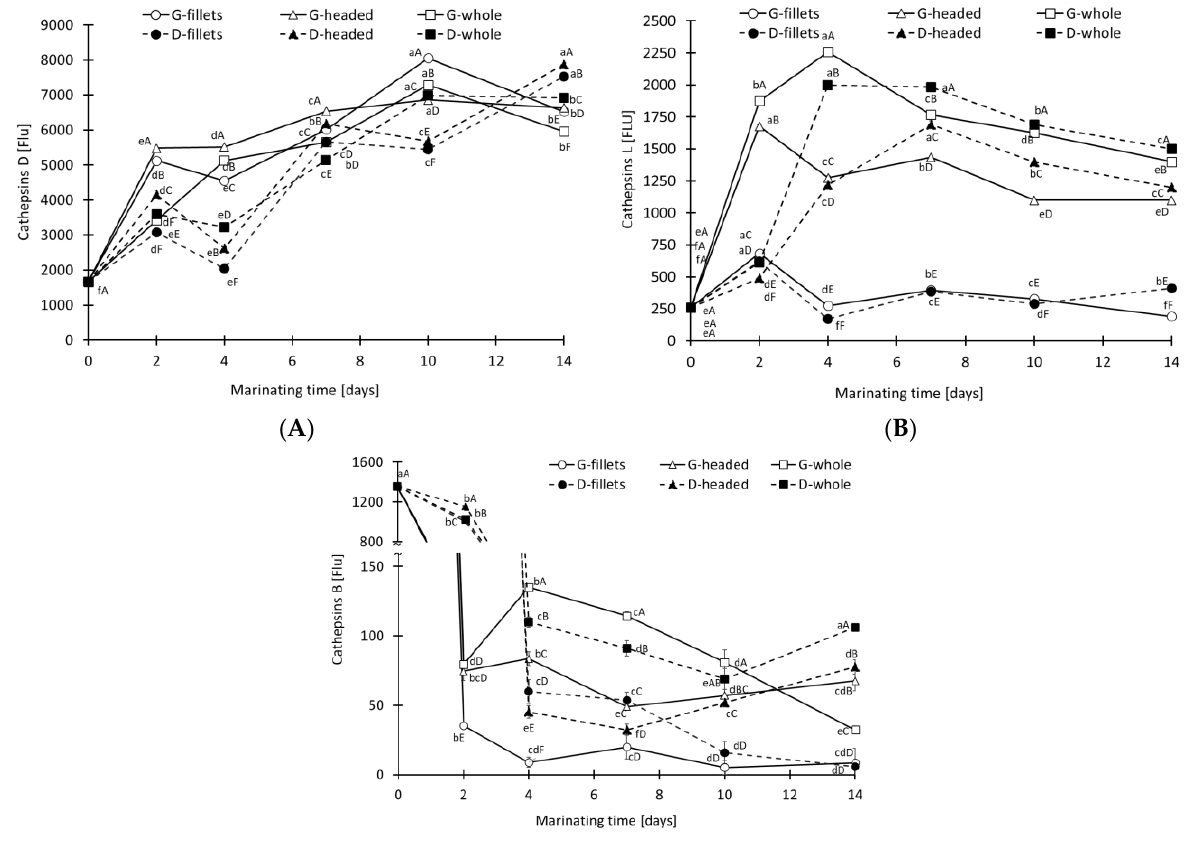
Figure 6. Effect of marinating method (G- — German, D- — Denmark) and degree of primary pro- cessing of Baltic herring (whole, headed, fillet) on activity of ( A ) cathepsin D, ( B ) cathepsin L and ( C ) cathepsin B during marinating. a,b,c Results marked with the same lower case letter do not statis- tically differ by the influence of marinating time; A,B,C Results marked with the same capital letter do not statistically differ by the influence of the marinating method. For a better presentation of the results, a break (≈) in the Y axis was used.